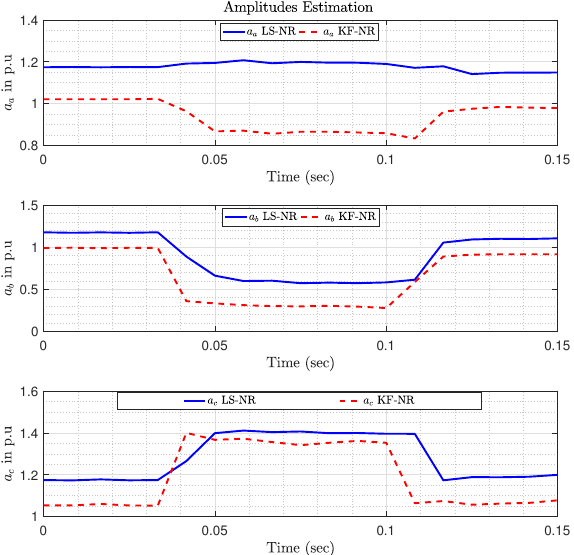
Figure 6. Amplitude variation of phasors: Comparison between least square (LS) and Kalman filter (KF) using NRA estimations (event